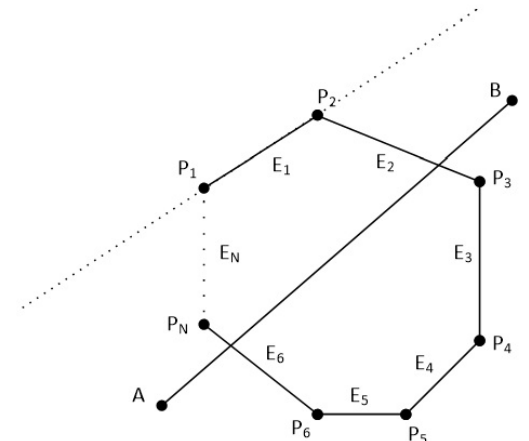
Figure 39. Checking if points A and B are left, right or on the edge E 1 of the polygon.